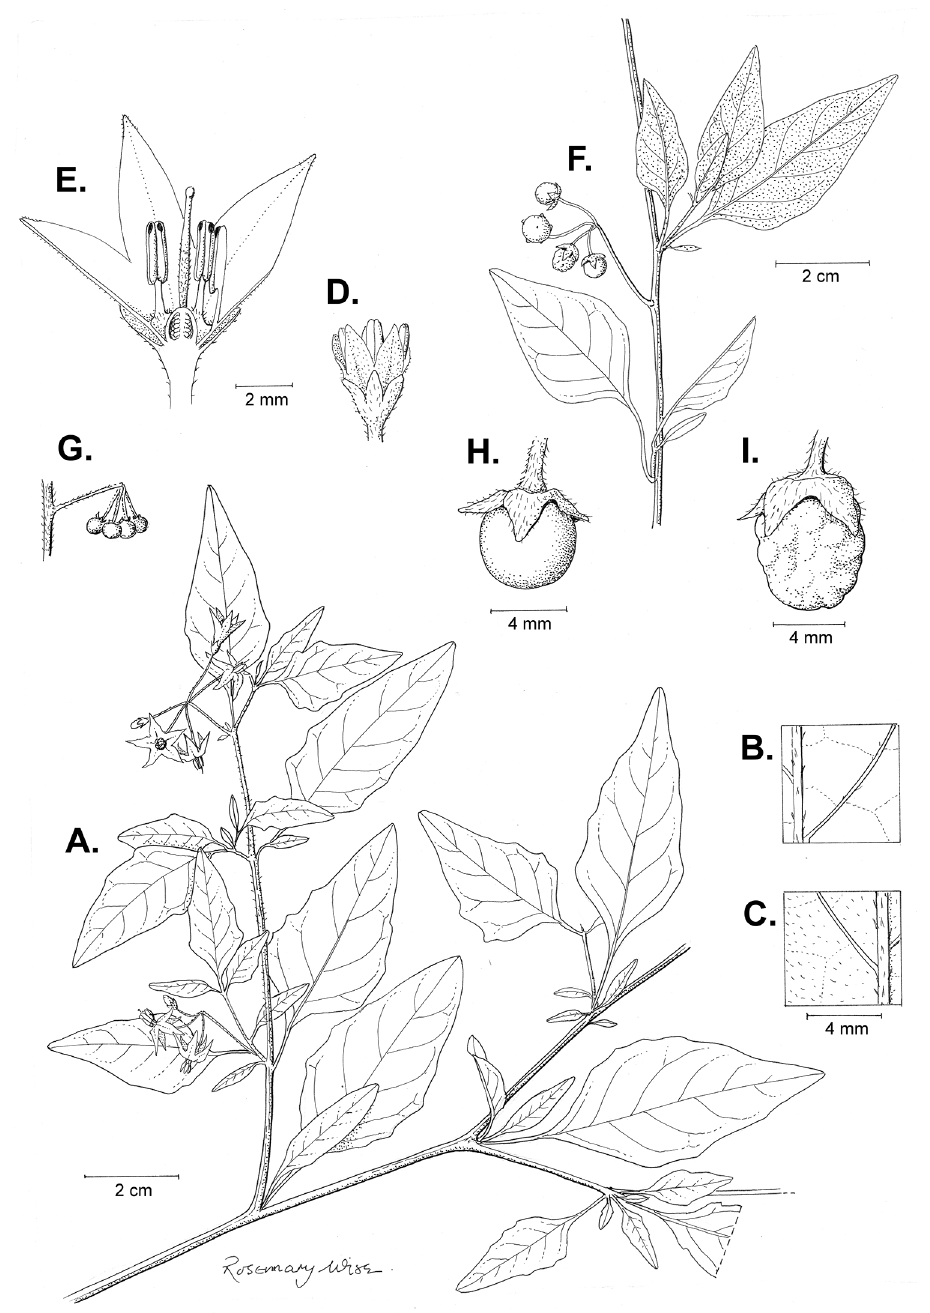
Figure 6. Solanum chenopodioides Lam. A Habit B detail of adaxial leaf surface C detail of abaxial leaf surface D opening bud E dissected flower F fruiting branch G detail of infructescence H maturing fruit I fully mature fruit ( A–E Fox s.n. F–I Hieronymus s.n. ). Drawing by R. Wise (previously published in “PhytoKeys